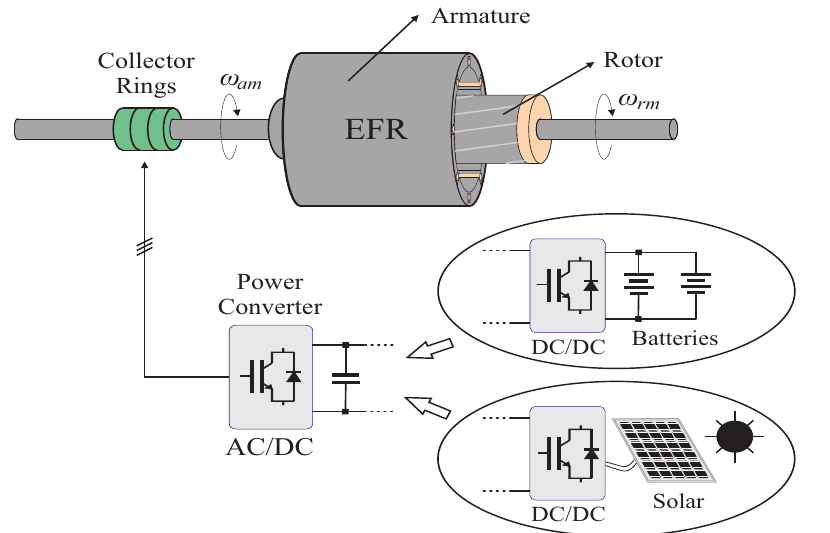
Figure 1. EFR’s construction